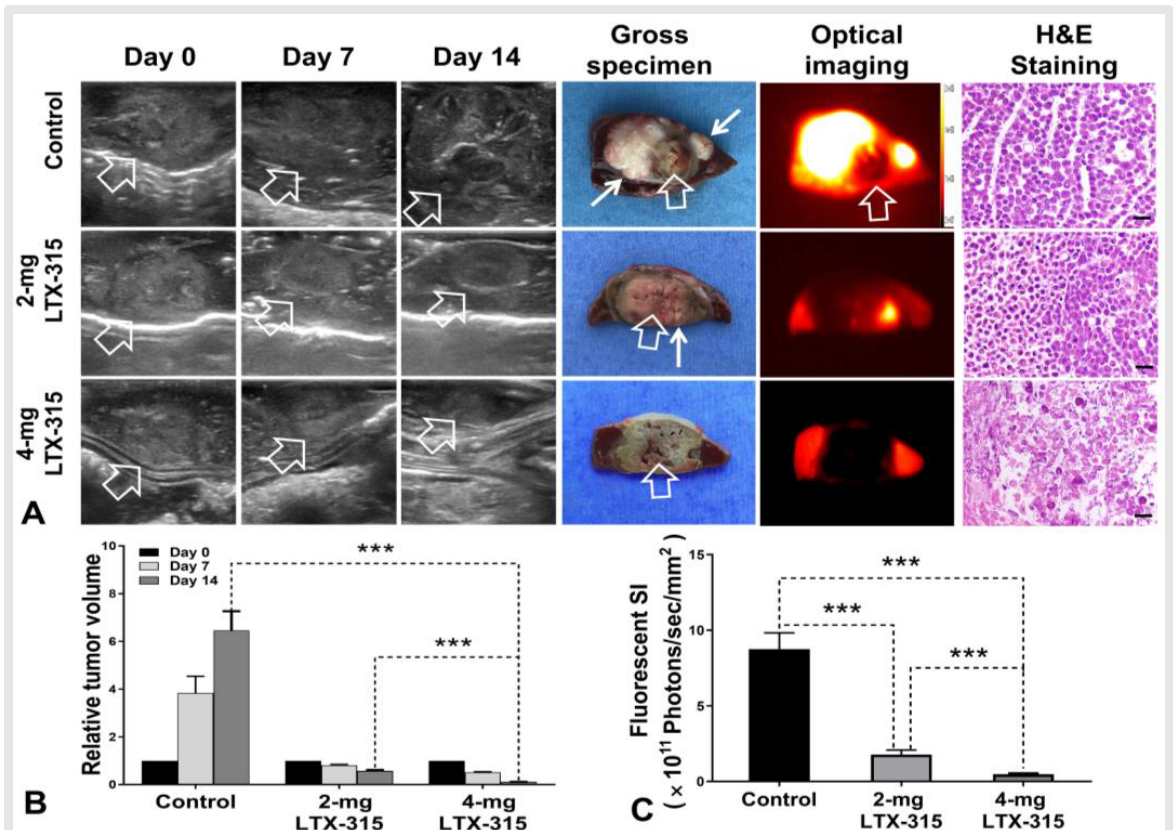
Figure 5. Follow-up of treated tumors among three animal groups. ( A ) The ultrasound images showed the smallest tumor size in the 4 mg LTX-315 therapy group compared with the other two groups, and the gross specimens of liver with the tumors showed the residual viable tumor in the ablated tumor margin appears as white color (small arrows), compared to RF-ablated necrotic (dead) tissues (grey-pink color, open arrows). ICG-based optical imaging detected these residual viable tumors as white-yellow color and the normal liver parenchyma surrounding the tumors as red color. H&E staining further confirmed the complete necrosis of tumor in the 4 mg LTX-315 therapy group, and there were viable residual tumor cells in the ablated tumor periphery in the other two groups (scale bars, 20 µ m). ( B ) The quantitative analysis demonstrated the smallest relative tumor volume in the 4 mg LTX-315 group compared with the other two groups, and the lowest signal intensity of the ablated tumor in the 4 mg LTX-315 group, in comparison to the other two groups ( C ). (*** p < 0.001).